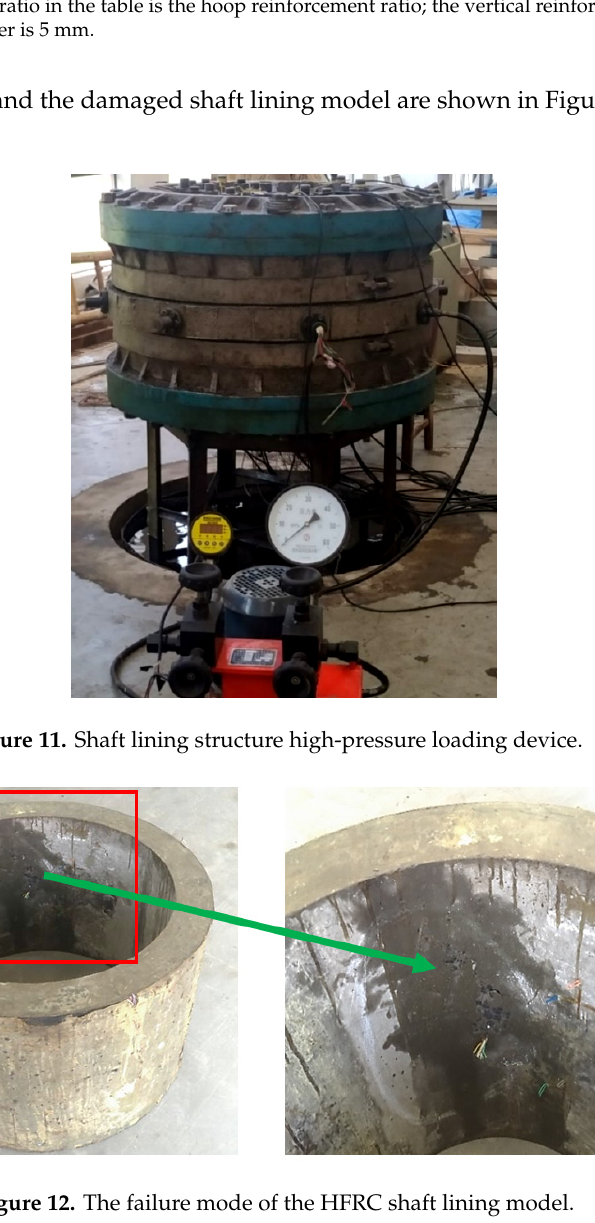
Figure 12. The failure mode of the HFRC shaft lining model.